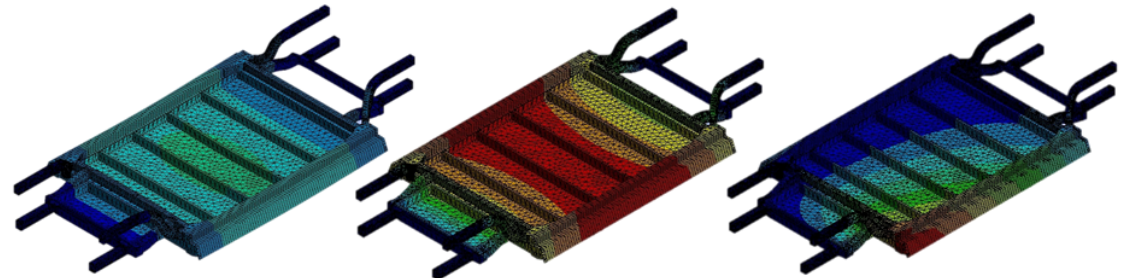
ground, taking as reference the position of each wheel centre. As to the torsional analysis